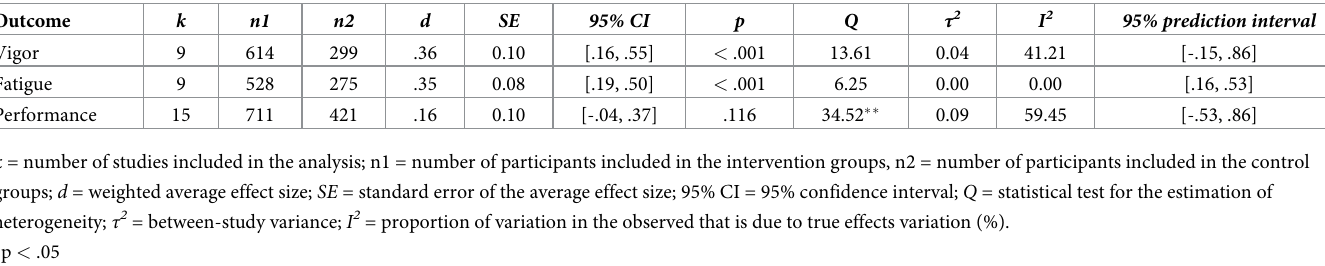
Table 3. Effectiveness of micro-breaks on vigor, fatigue, and